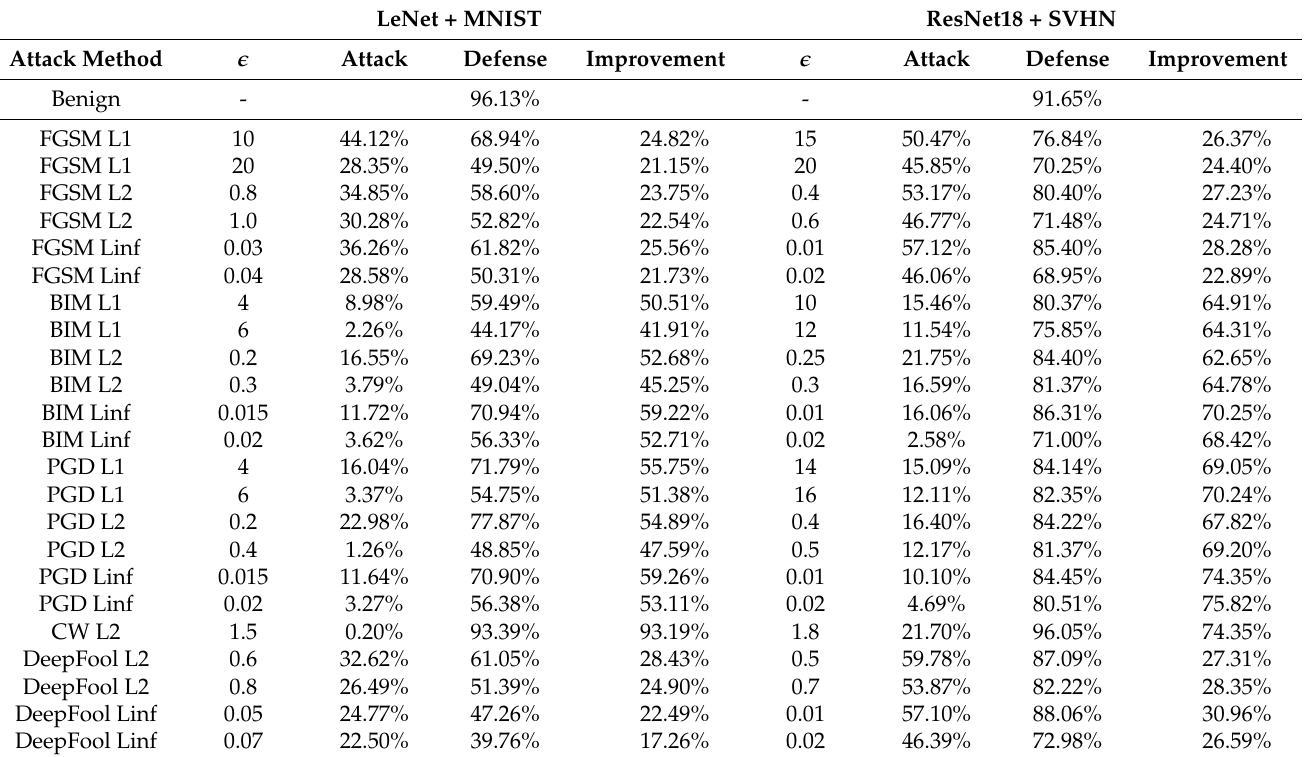
Table 5. Defense against adversarial attacks by MAD for LeNet (with the MNIST dataset) and ResNet18 (with the SVHN